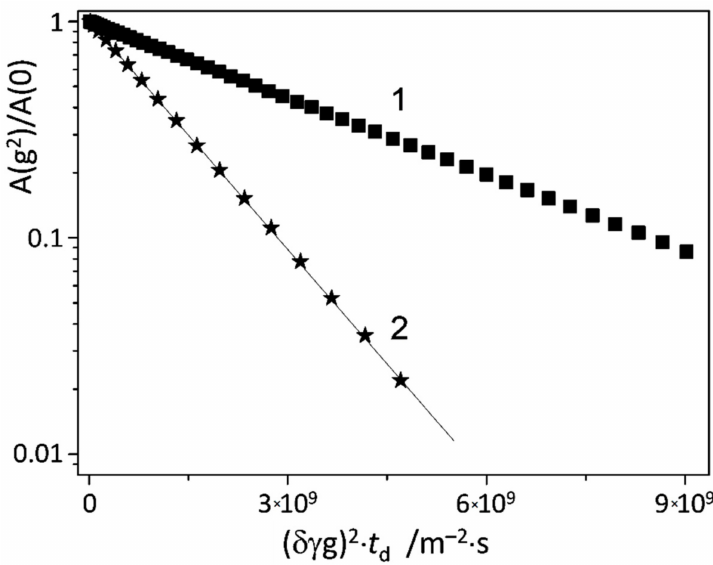
Figure 7. Di ff usion attenuations of spin–echo signals for the anomeric CH proton of β -CD (1, squares) and CH proton of 5-FU (2, stars). The sample contained only β -CD (1) or only 5-FU (2) in D 2 O solution at 298